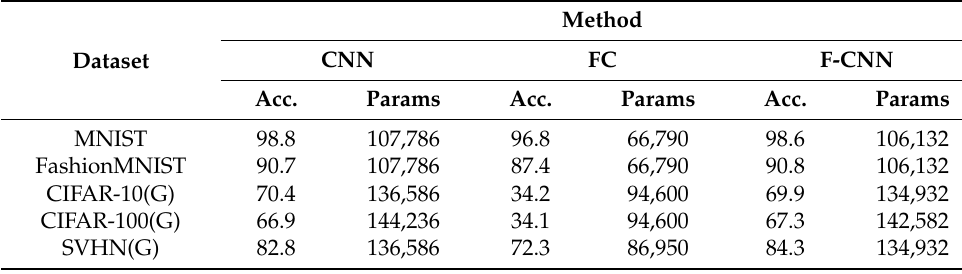
Table 2. Accuracy (%) of LeNet-3 on gray-scale image datasets.